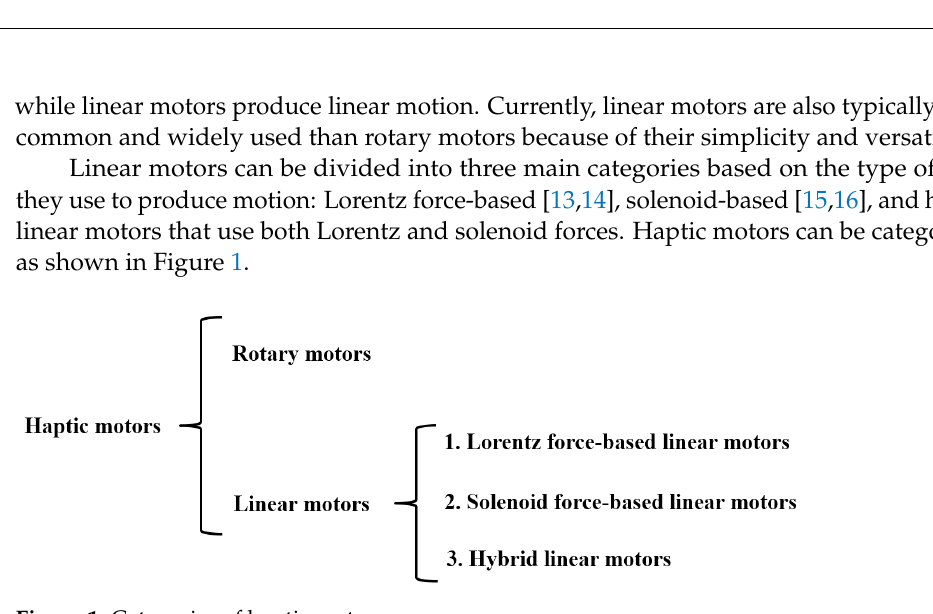
Figure 1. Categories of haptic motors.